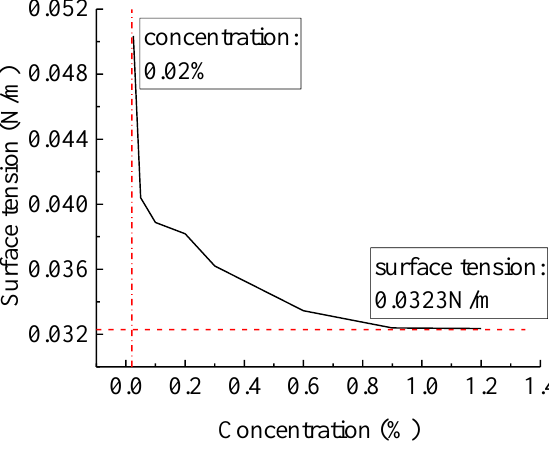
Figure 3. Surface tension changes with butachlor concentration.